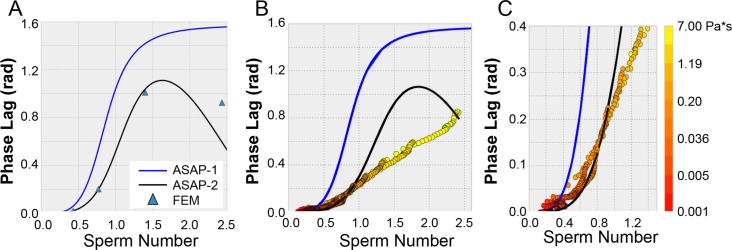
Phase lag of ASAP vs. sperm number.(A) Plots of the phase vs Sp for the ASAP-1 model, blue, the FEM model, blue triangles, and ASAP-2, black. (B) A plot of the two analytical models, and experimental results as a function of Sp. The blue line represents the ASAP-1 model which over estimates the phase at all Sp as compared to the ASAP-2 model. Circles represent experimental results at different Sp, color indicates the viscosity of the sample (logarithmic scale on right side of figure). Sp was adjusted by both changing the frequency and viscosity of the samples. At Sp ~ 1, the ASAP-2 model (black) deviates significantly from the experimental results. Note that the ASAP-2 curves in A and B are slightly different due to differing input shell length parameter to match the FEM and experimental ASAP geometries respectively. (C) Zoomed-in view of B in the low sperm number range.